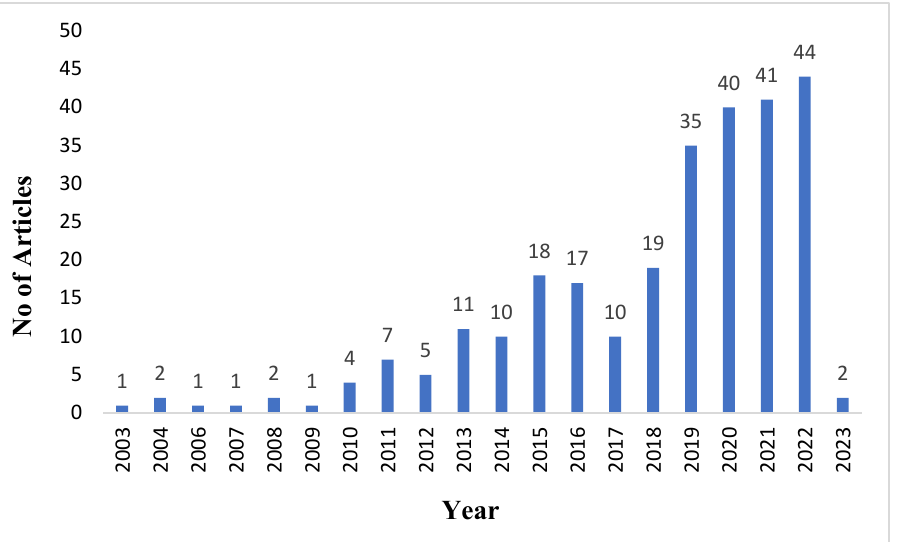
Figure 3. The numbers of publications change over the years. Table 3. The research country’s production rates over time. SL.